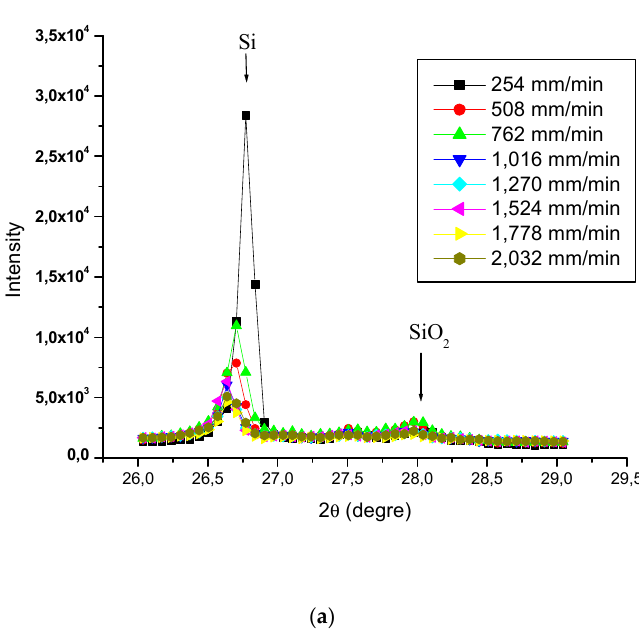
Figure 3. XRD patterns obtained at different polishing rotation speeds for ( a ) white granite, and ( b ) Black granite (Canadian anorthosite), using 508 mm/min feed rate, 0.2 bar pressure, and 60 grit abrasive.